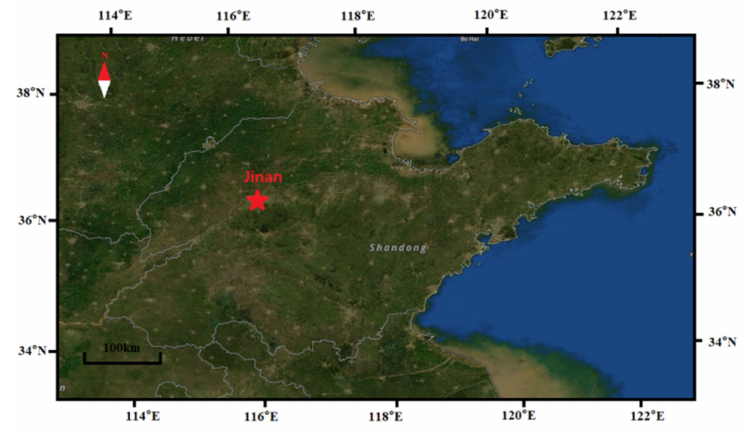
Figure 1. The geographic locations of the monitoring sites.